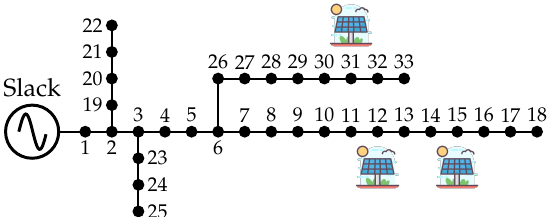
Figure 5. Proposed configuration of the IEEE 33-bus grid for simulating the operation scenario in the city of